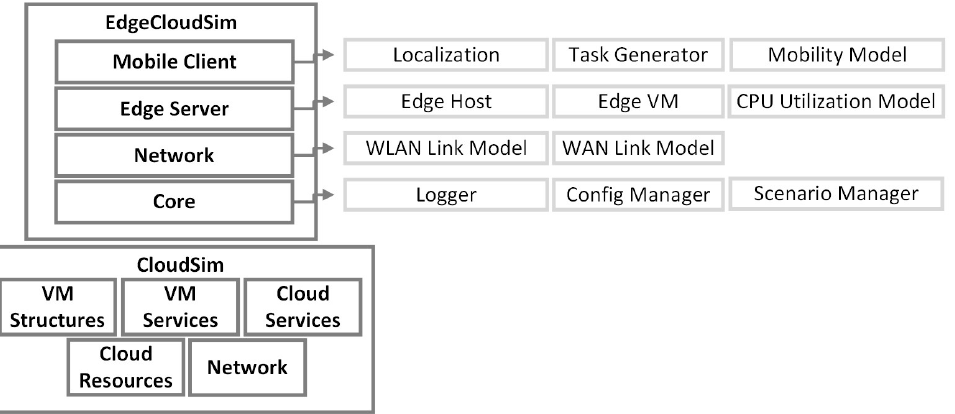
Figure 3. EdgeCloudSim Architecture (Adapted from